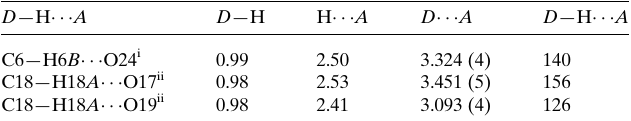
Table 1 Hydrogen-bond geometry (A˚ , (cid:3) ).